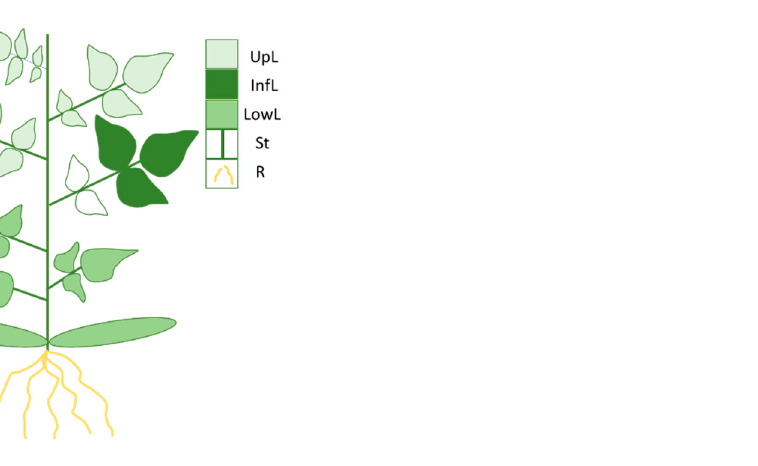
Figure 8. Scheme of plant parts harvested. Twelve larvae of T. absoluta were deposited on the 3 terminal leaflets of the 4th leaf. After 4 and 7 days of herbivory, these 3 infested leaflets were harvested (InfL). The other plant parts were harvested as indicated: upper leaves (UpL), lower leaves (LowL), stem (St) and roots (R).